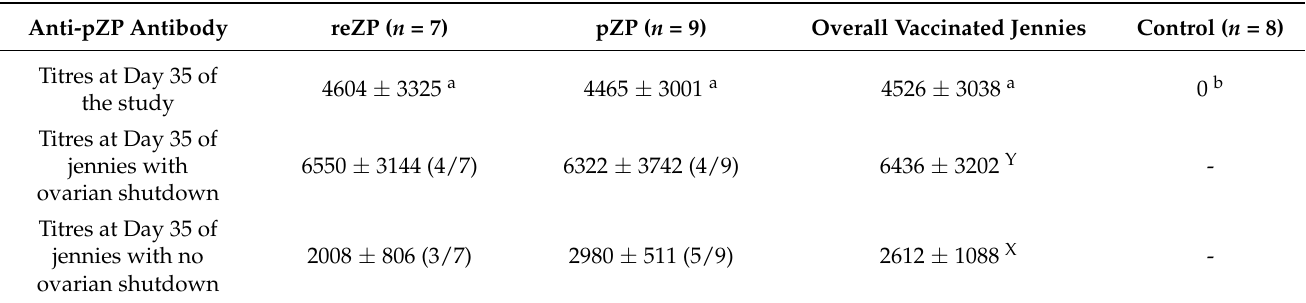
were administered on Days − 35 and 0. Superscript letter ( a,b ) denote difference between groups, and ( X,Y ) within columns ( p <